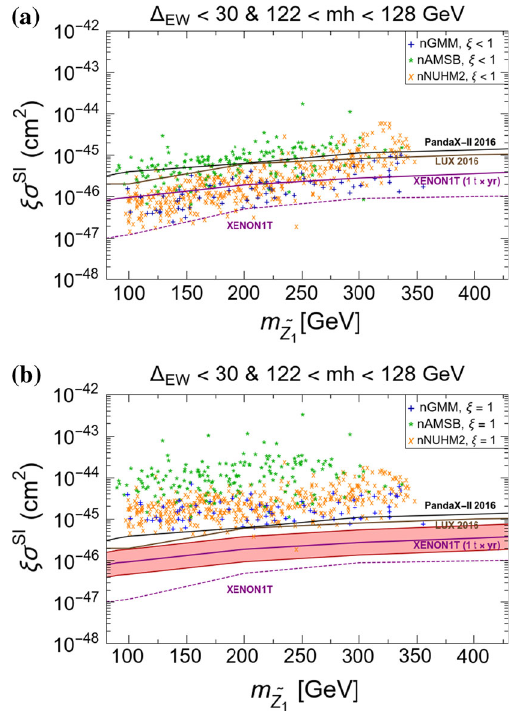
Fig. 2 Plot of points in the σ SI ( (cid:2) Z 1 p ) vs. m (cid:2) Z 1 plane from a scan over the natural NUHM2, nGMM and nAMSB model parameter space for a ξ < 1, assuming the neutralino relic density is given by its thermal value, and b ξ =